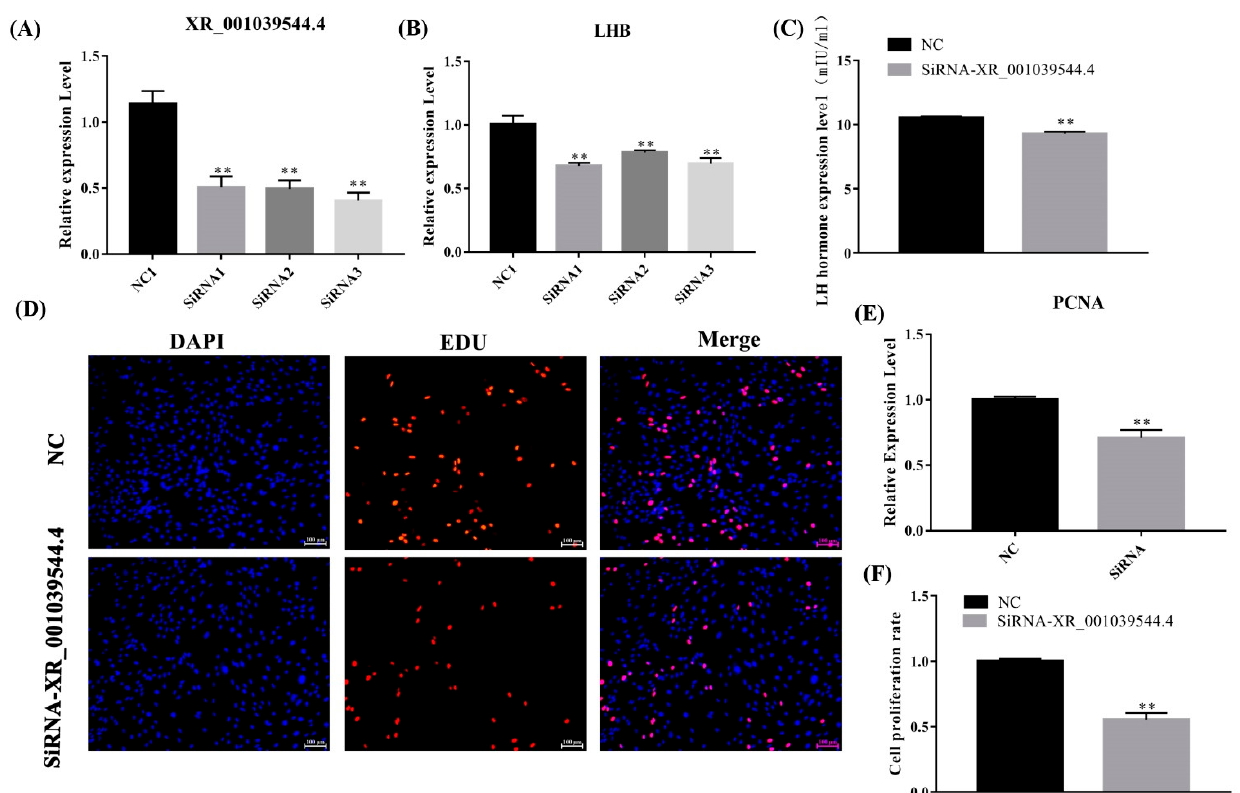
Figure 9. LncRNA XR_001039544.4 knockdown inhibits the secretion of gonadotropins in pituitary cells. ( A – B ) mRNA expression of lncRNA XR_001039544.4 and LHB in sheep pituitary cells treated with siRNAs were decreased compared to the negative control (NC), as determined by qPCR. ( C ) LH secretion was detected by ELISA. ( E ) mRNA expression of PCNA in lncRNA XR_001039544.4-knockdown pituitary cells. ( D and F ) Pituitary-cell proliferation was detected using EDU. Scale bars, 100 μ m. The data are shown as the mean ± SEM of at least three independent experiments. Statistical significance was analyzed by one-way ANOVA and Student t-test ( ∗∗ p <